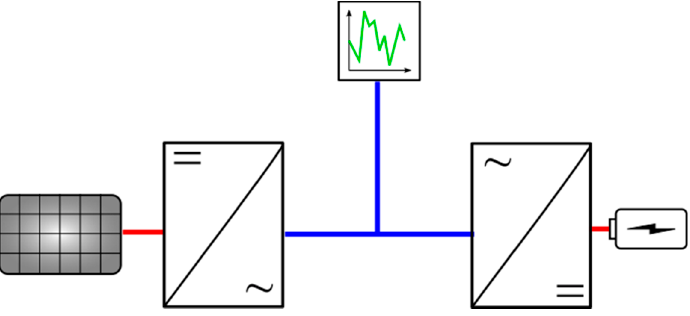
Figure 14 . The layout of the developed PV system simulation model. Figure 14. The layout of the developed PV system simulation